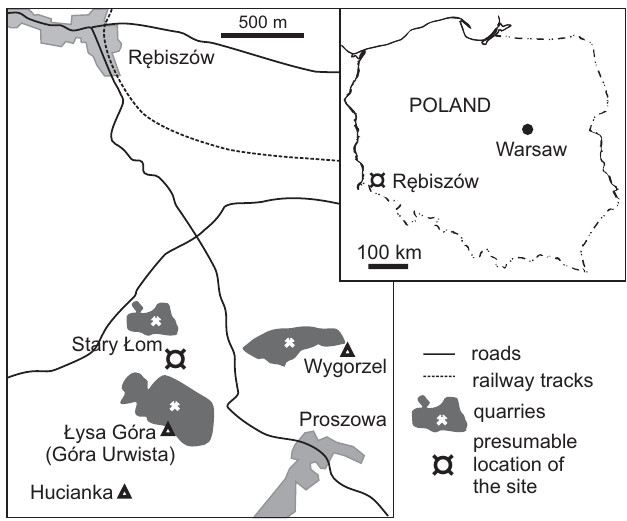
Fig. 1. Location of the Ł ysa Góra near R ę biszów, Lower Silesia,